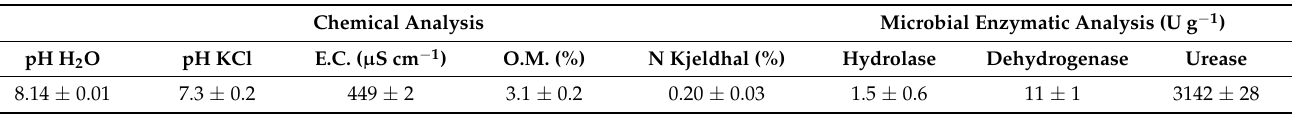
Table 1. Chemical and biological characterization of soil. Data present the mean ± standard deviation of three repli- cated